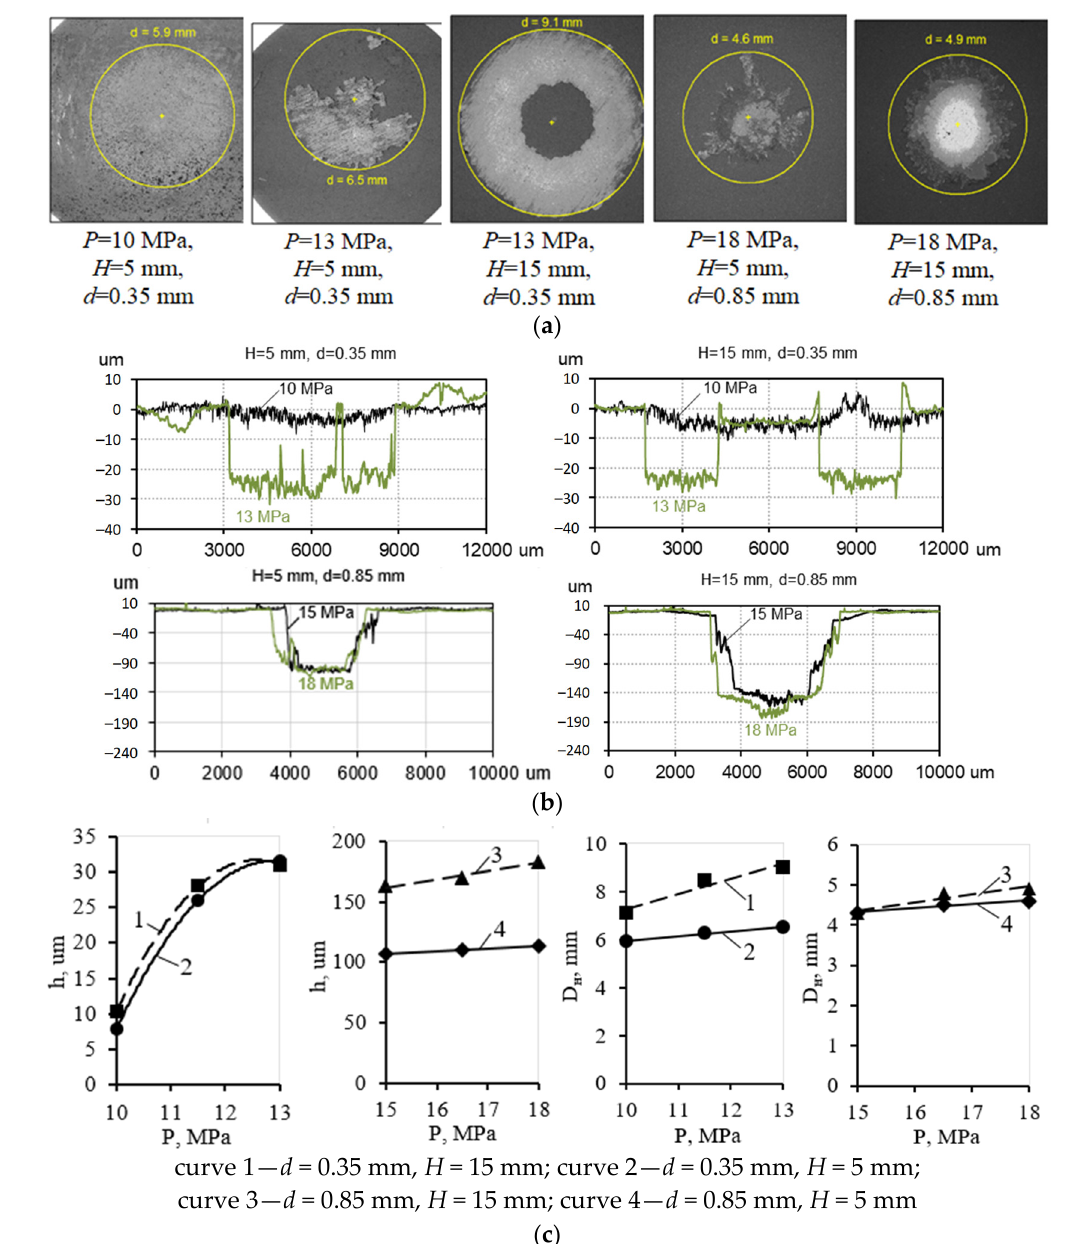
curve 1— d = 0.35 mm, H = 15 mm; curve 2— d = 0.35 mm, H = 5 mm; curve 3— d = 0.85 mm, H = 15 mm; curve 4— d = 0.85 mm, H = 5 mm Figure 5. Patterns of surface changes in cavitation mark area ( a ), surface profiles ( b ), and cavitation mark depth h and cavitation mark diameter D out ( c ) determined by them during cavitation tests of coated aluminum samples.